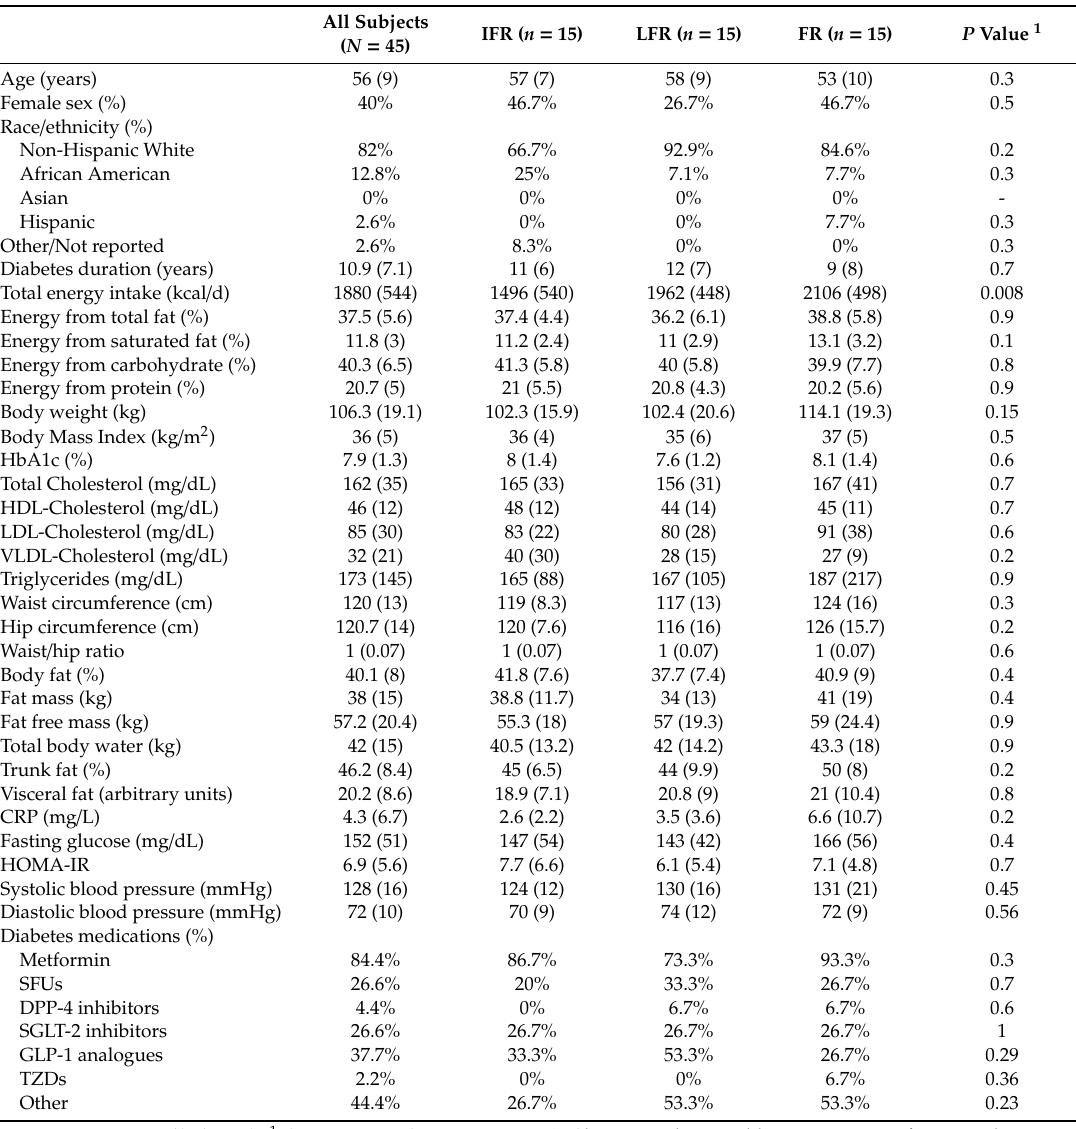
Table 1. Baseline demographic, dietary, and clinical characteristics of study subjects with type 2. diabetes and overweight or obesity stratified by frequency of dairy